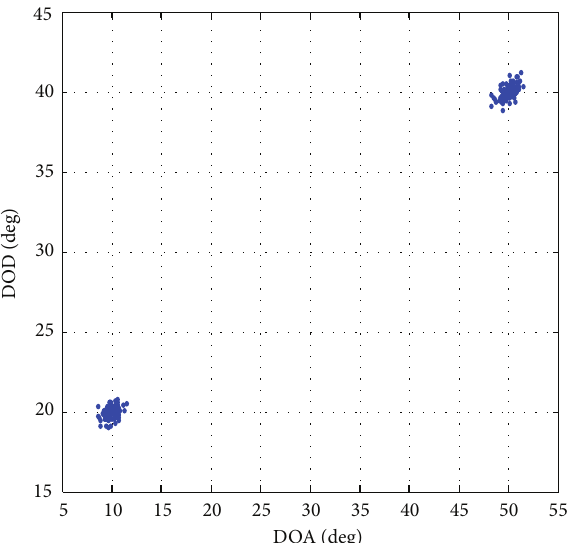
Figure 1: The angle estimation result of two